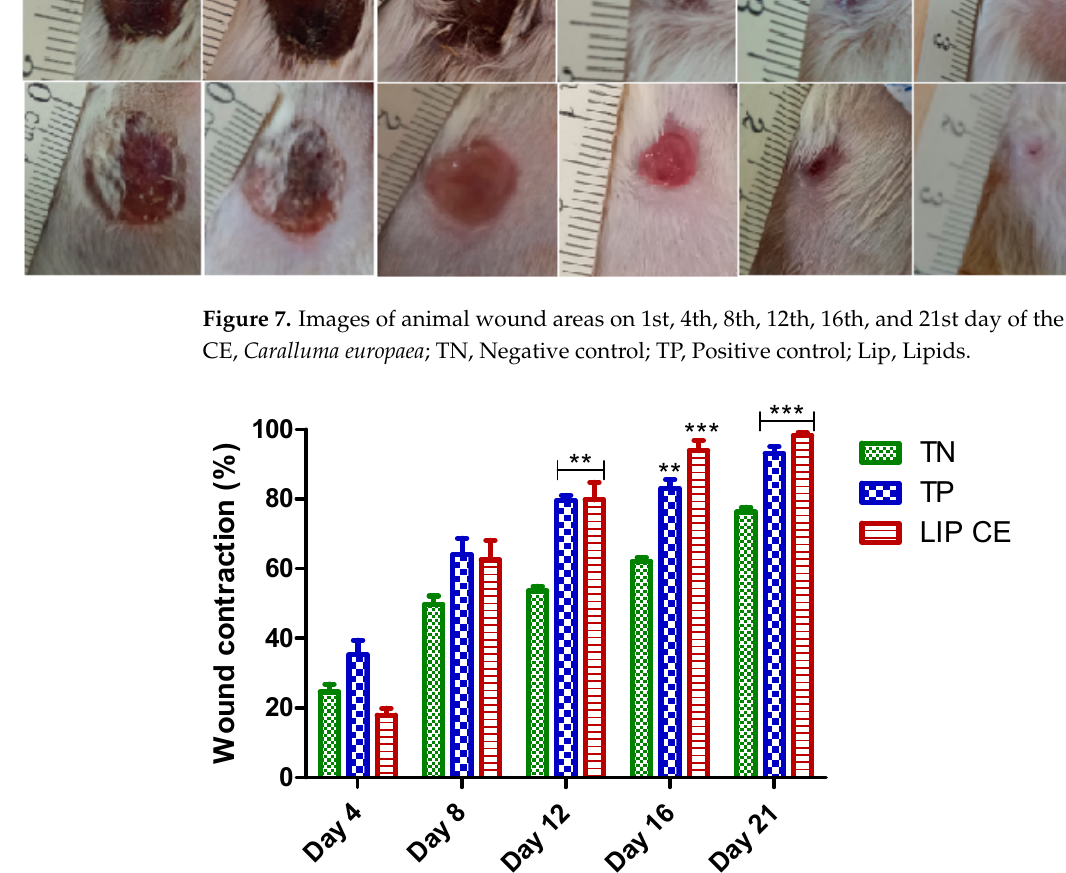
Figure 8. Wound contraction rate (%) in 4th, 8th, 12th, 16th, and 21st day of treatment. Values are significantly different in comparison with the negative control. **: p < 0.01, ***: p < 0.001.